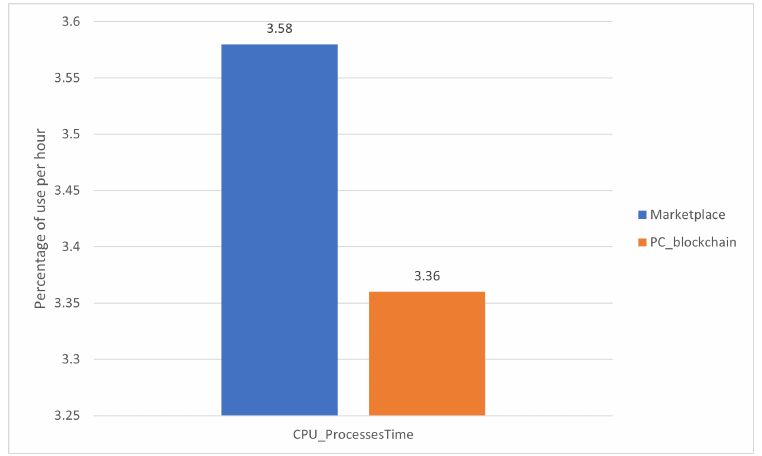
Figure 8. Comparison of CPU usage metric between the proposed marketplace and an analogue blockchain over a PC.